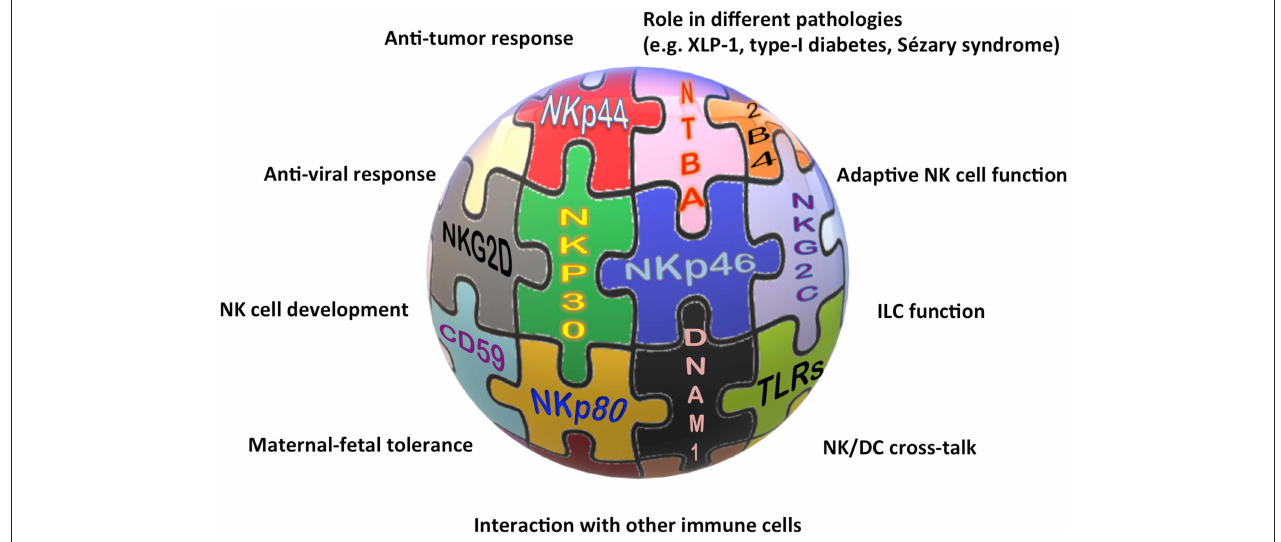
FIGURE 1 | The “activating” solution of the NK cell puzzle. Different activating receptors collaborate to induce NK cell triggering in healthy and pathological conditions.